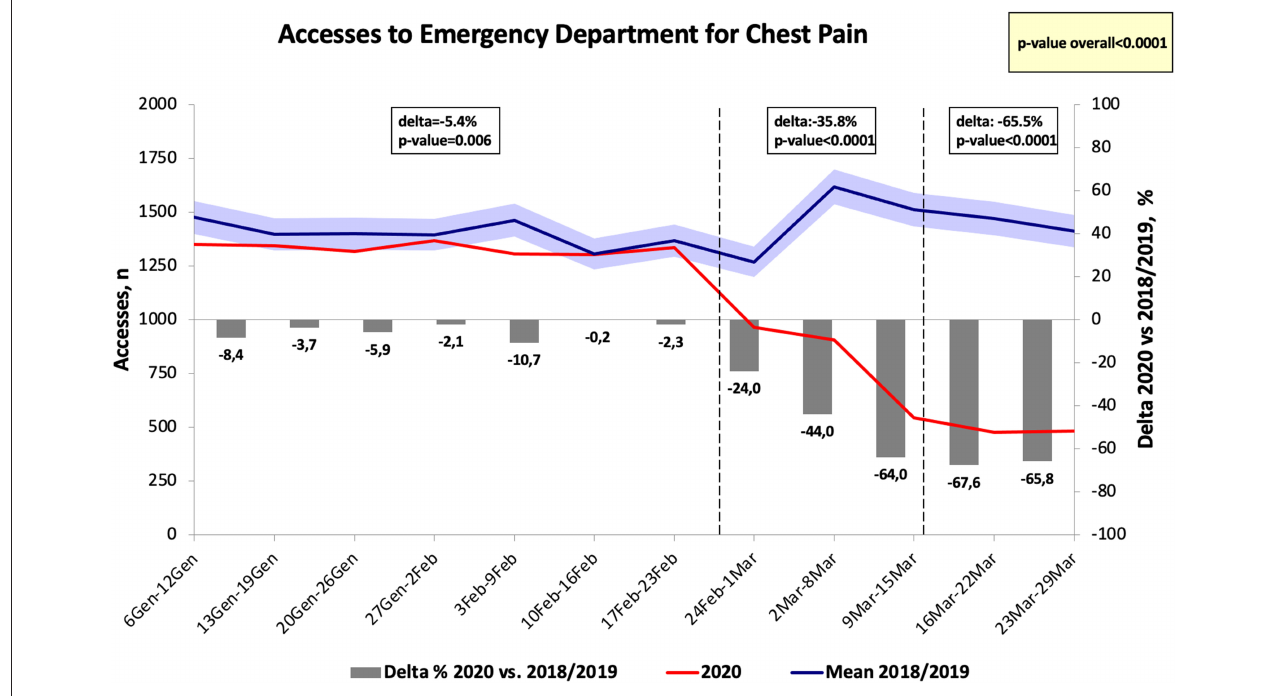
FIGURE 2 | Number of accesses to emergency department for chest pain in Tuscany.